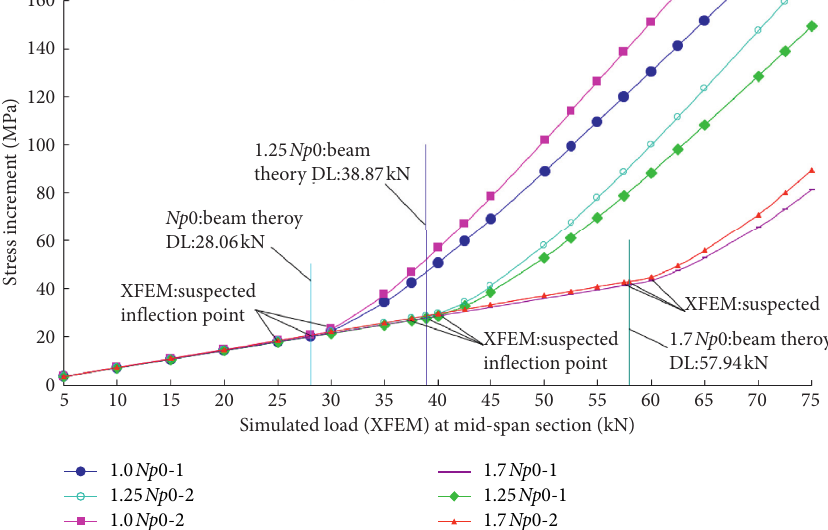
Figure 9: Stress increment vs. load curves by the traditional method (rebar data).